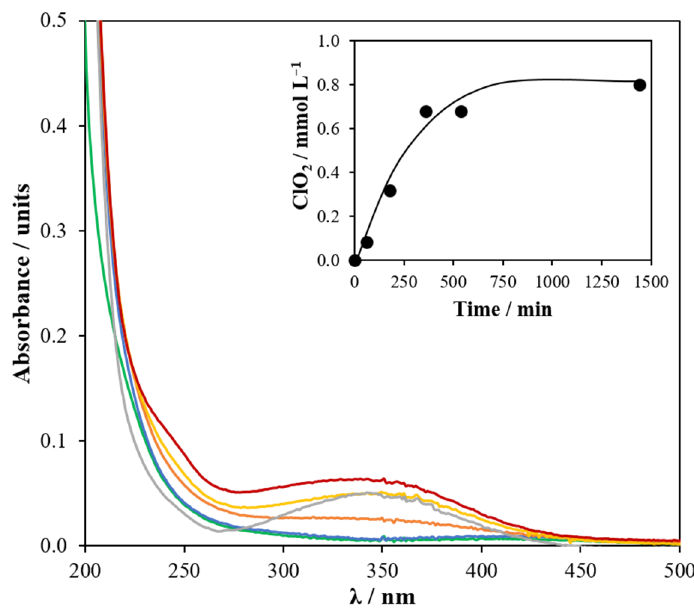
Figure 7. Changes in the UV-vis spectra during production of chlorine dioxide in the liquid reaction mixture from electrochemically generated hydrogen peroxide and chlorate in test EQII. The inset panel shows the concentration of chlorine dioxide produced in the system during the reaction. Legend: ( ▬ ) 0 min, ( ▬ ) 60 min, ( ▬ ) 180 min, ( ▬ ) 240 min, ( ▬ ) 540 min and ( ▬ ) 1440 min.